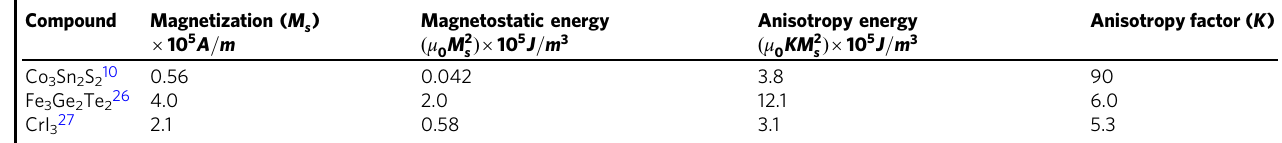
Fig. 4 Magnetic susceptibility and 2D Ising transition. a Magnetization versus magnetic fi eld along out-of-plane ( z ) and in-plane ( x ) directions, respectively. b Magnetic susceptibility plotted against temperature. The in-plane susceptibility data divided by 8 for clarity. c Effective mobility, μ the DW is plotted against τ (cid:4) 4 χ c = χ ab , which is the control parameter for the linear wall phase transition. The μ mobility predicted by the 2D Ising model (red dotted line) 24 , but not with the mean- fi eld theory (blue dotted line), which predict a phase transition at τ (cid:6) (cid:7) 1. Error bars represent the uncertainties of least square fi tting of